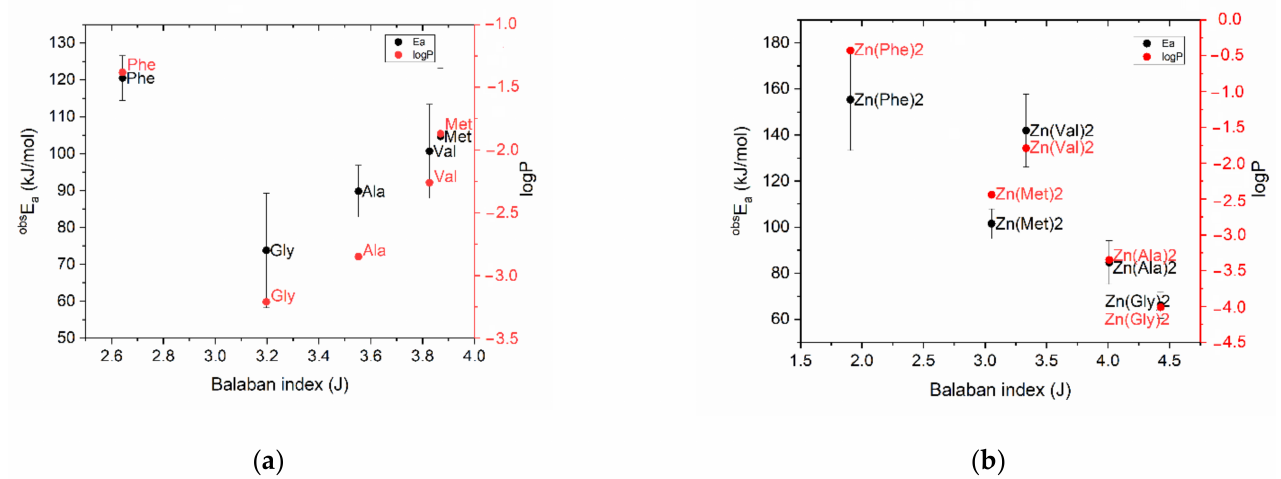
Figure 3. Dependence of biological activity ( obs Ea) and lipophilicity on Balaban index for amino acids ( a ) and for their chelate compounds with Zn ( b